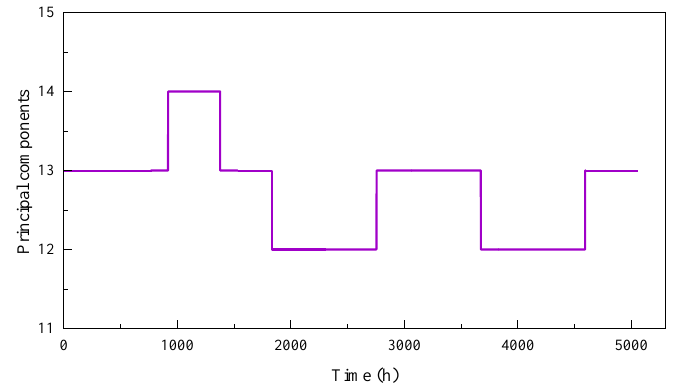
Figure 7. The number of features varying with